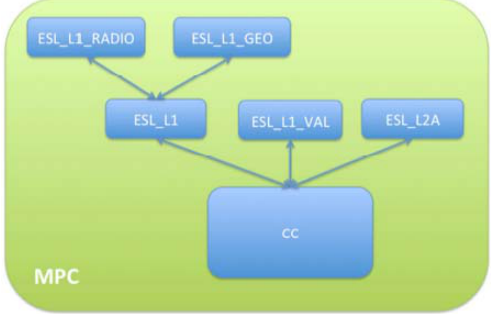
Figure 1. MPC/ ESL organization layout © ESA.